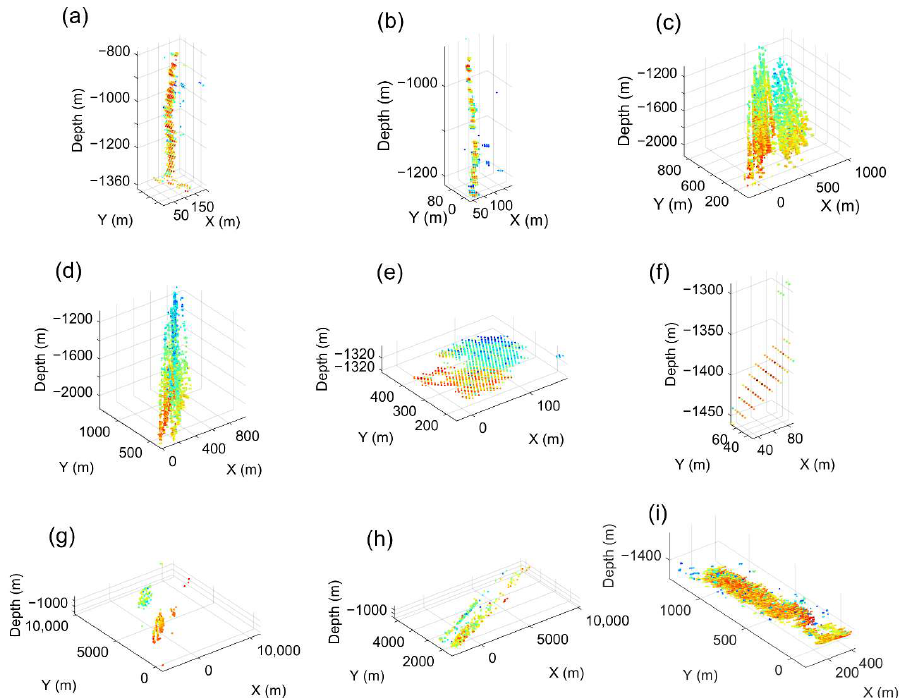
Figure 13. Extraction of some candidate point clouds by the DBSCAN algorithm. The data from the experimental area is parsed and the high reflection intensity clustering point cloud in MWC is extracted using the method in this paper, where ( a , b ) is a single plume, ( c , d ) is a dense plume over a large area in the gas leakage area, and ( e – i ) is an unusually high density of noise in MWC. Then, the target detection of the candidate point clouds was performed through the method and threshold selection in Section 2.4 of this paper, candidate point clouds with scores less than 0.1 were selected, and finally, the plume target detection results were out- put, verifying the location of the plume seepage nozzle compared with those observed in real time during the cruise (Figure 14).